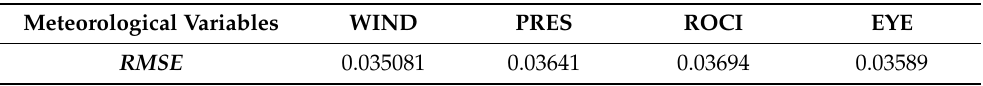
Table 2. Error evaluation results for missing